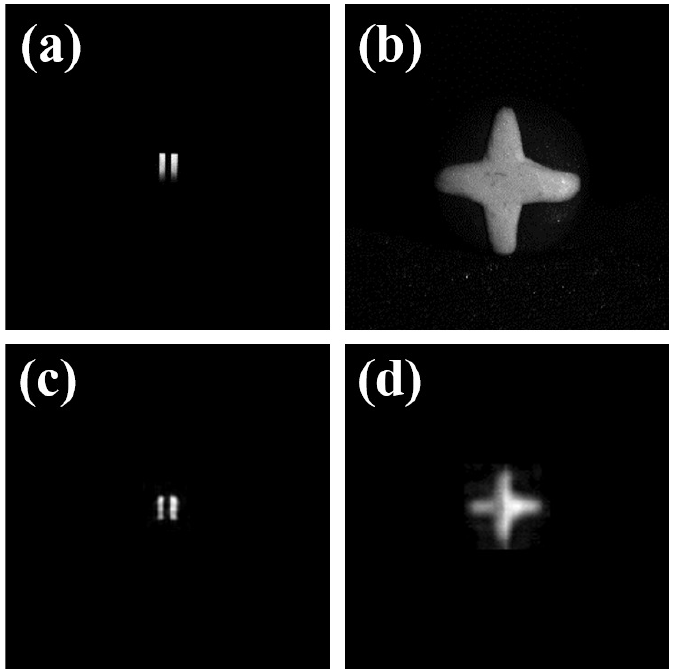
Figure 9. Photographs and reconstructed images of two objects: ( a ) the photograph of a double-slit, ( b ) the photograph of a starfish, ( c , d ) the reconstructed images of the double-slit and starfish,